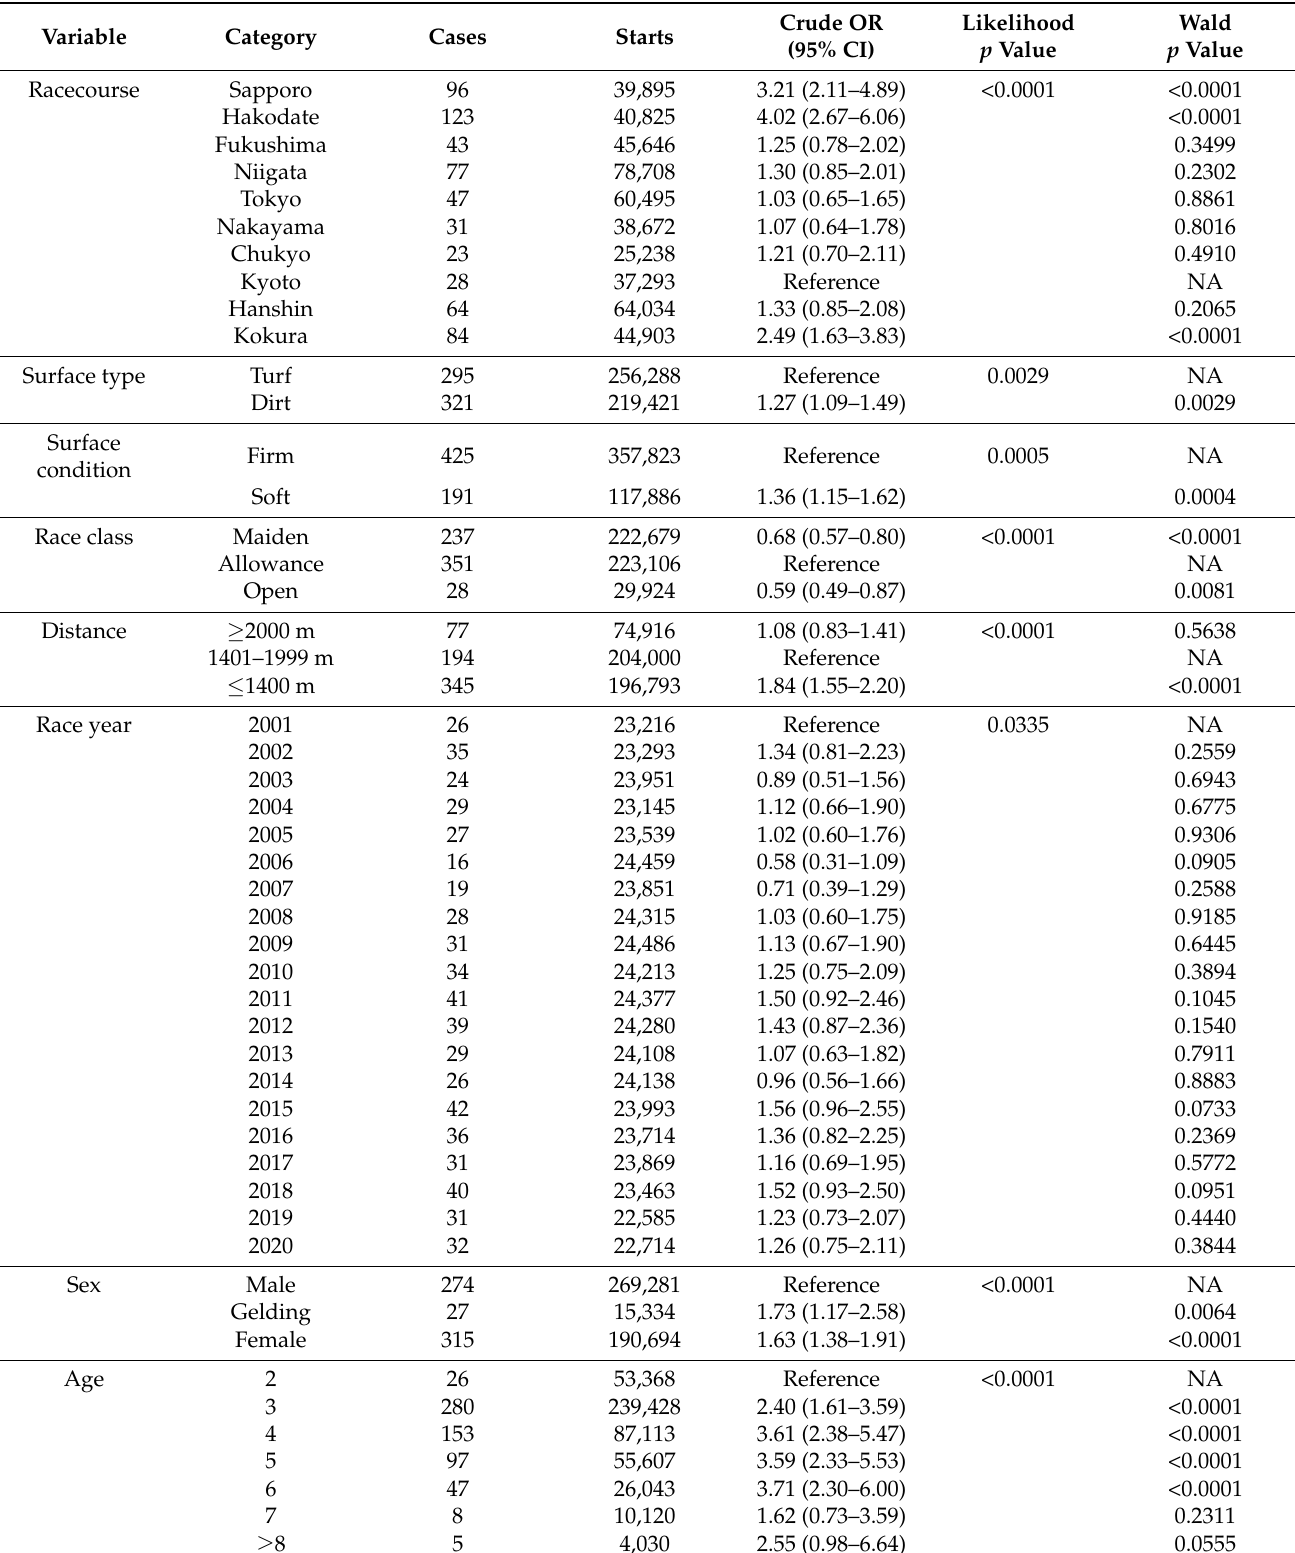
Table 2. Numbers of cases and starts implemented by the Japan Racing Association between April and September of 2001 to 2020, with the results of the univariable analysis, stratified by each variable’s category. The Wald p value of the reference was not applicable (NA). OR, odds ratio; CI, confidence